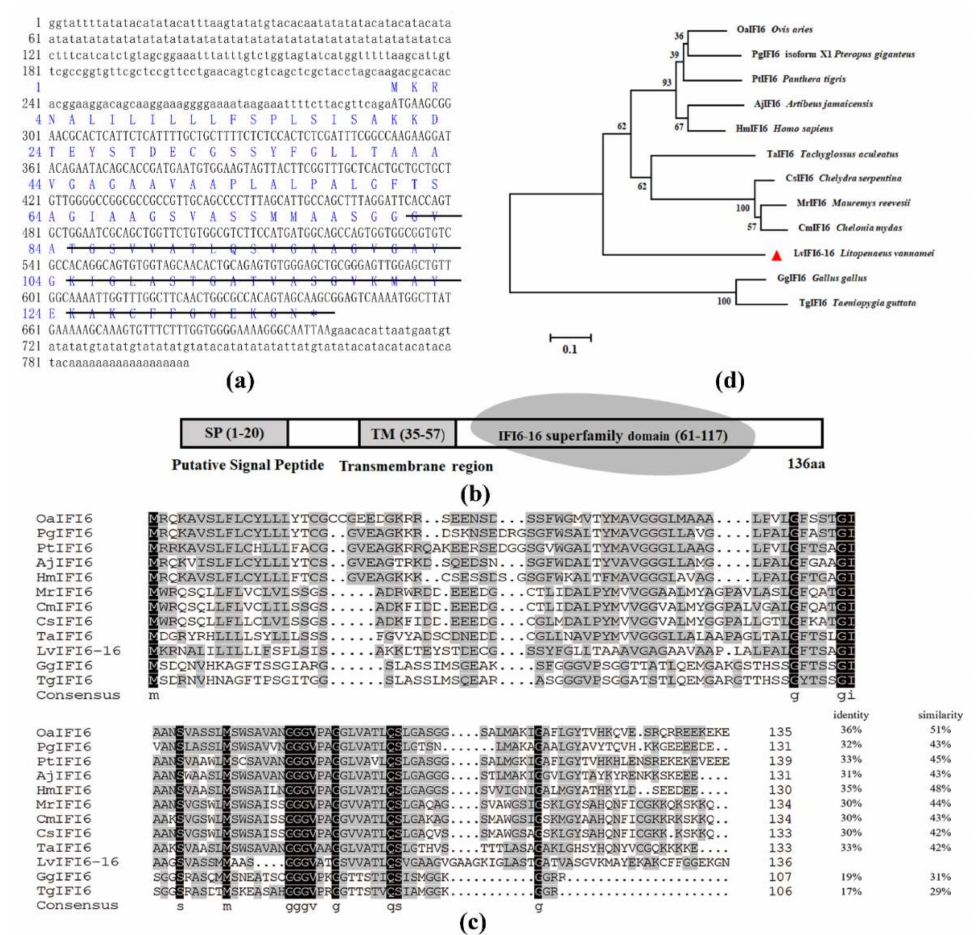
Figure 1. The sequence and phylogenetic analysis of LvIFI6-16. ( a ) The full-length cDNA sequence and deduced amino acid sequence of LvIFI6-16. The IFI-6-16 superfamily domain was under- lined with a black line. ( b ) Structural features of LvIFI6-16 protein contained a putative signal peptide, a transmembrane region, and an IFI-6-16 superfamily domain. ( c ) Multiple sequence alignment of IFI6-16 homologs. The identical amino acid residues are shaded in black and the similar residues in gray. Amino acid identity and similarity of the LvIFI6-16 with other IFI6-16 homologs were shown on the right. ( d ) Evolutionary pattern of IFI6 homologs based on phylogeny. Phylogenetic tree analysis was based on the full-length amino acid sequences of IFI6-16 proteins (LvIFI6-16 was marked with a triangle) using MEGA7.1 software. Proteins analyzed listed below: Litopenaeus vannamei IFI6-16 (ON186541); Panthera tigris IFI6 (XP_042852994.1); Gallus gallus